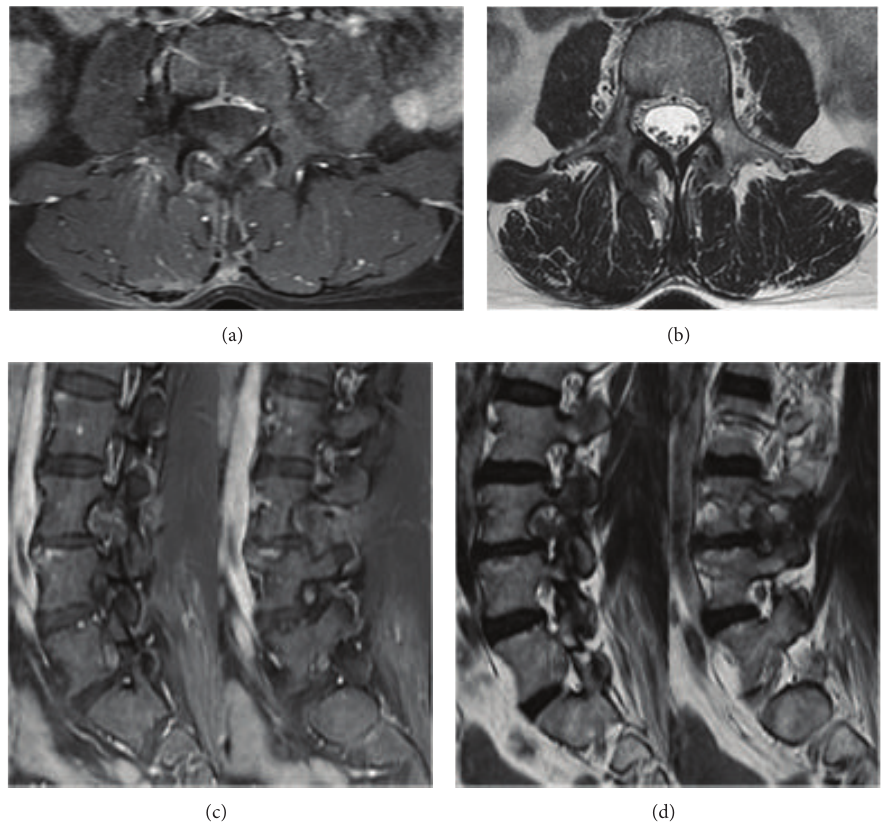
Figure 9: Postoperative MRI demonstrates gross total resection of the tumor and postoperative changes with no muscle atrophy: (a) axial T1-weighted with gadolinium enhancement; (b) T2-weighted; (c) sagittal T1-weighted with gadolinium enhancement; (d)